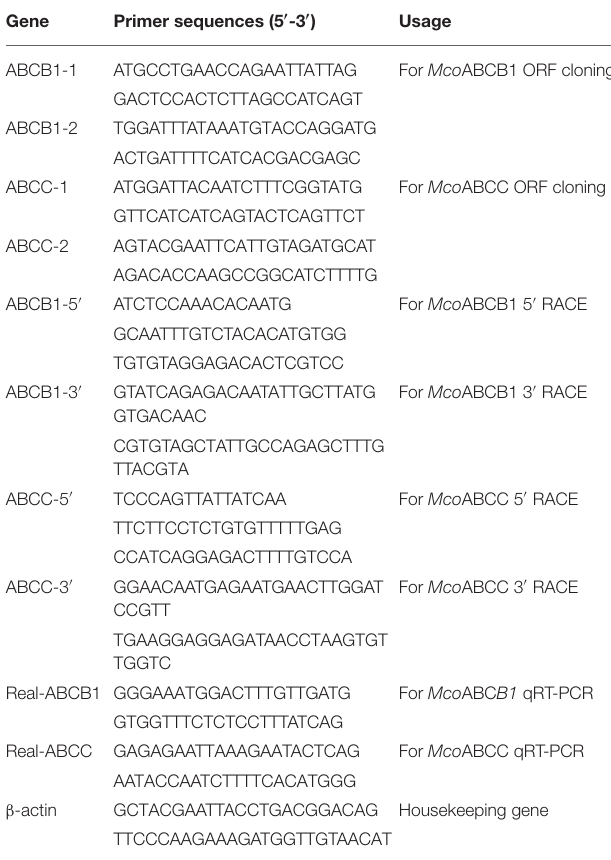
TABLE 1 | Primer sequences used for ORF cloning, RACE and